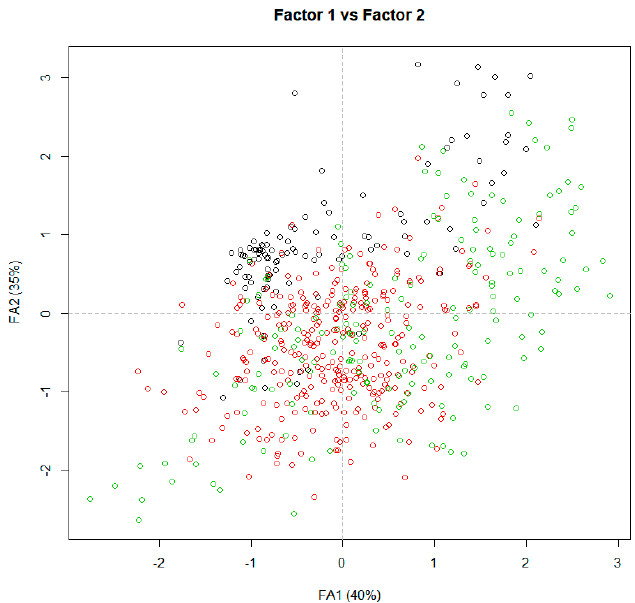
Figure 2. Projection of the Central (green), Western (black), and Eastern (red) regions for the first and second factors (FA1 and FA2, respectively).